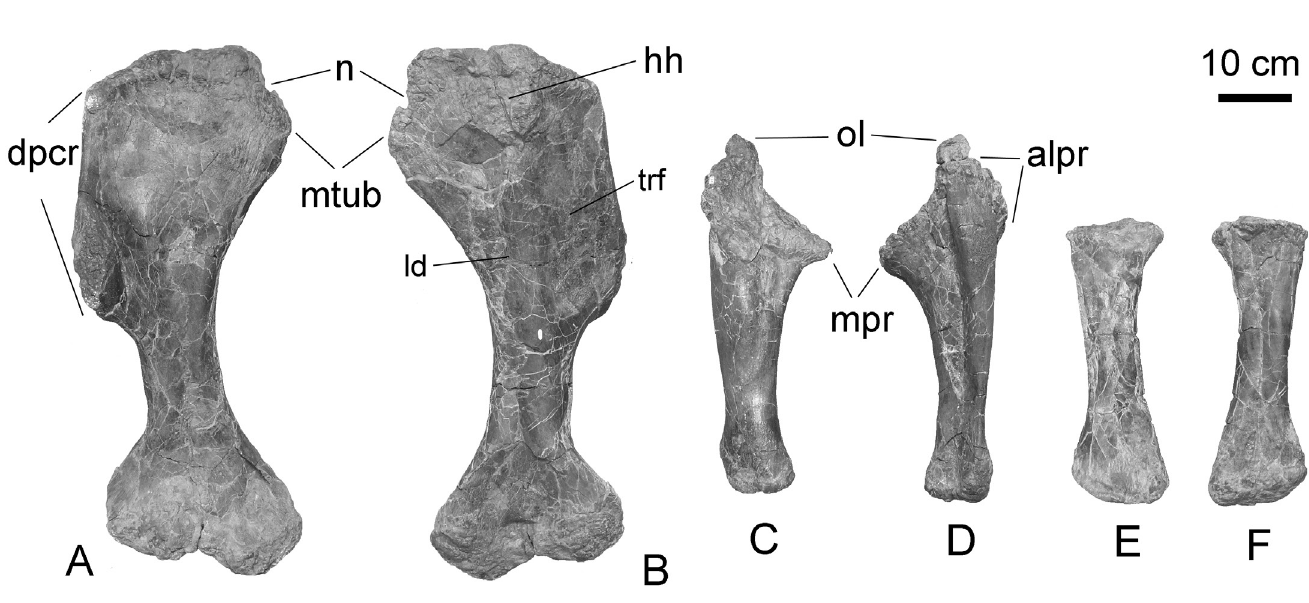
Figure 17. A, B, right humerus in A, flexor (ventral) and B, extensor (dorsal) views; C, D, right ulna in C, anteromedial and D, posterolateral views; E, F, right radius in radius in E, anteromedial and F, posterolateral views. Vagaceratops irvinensis , CMN